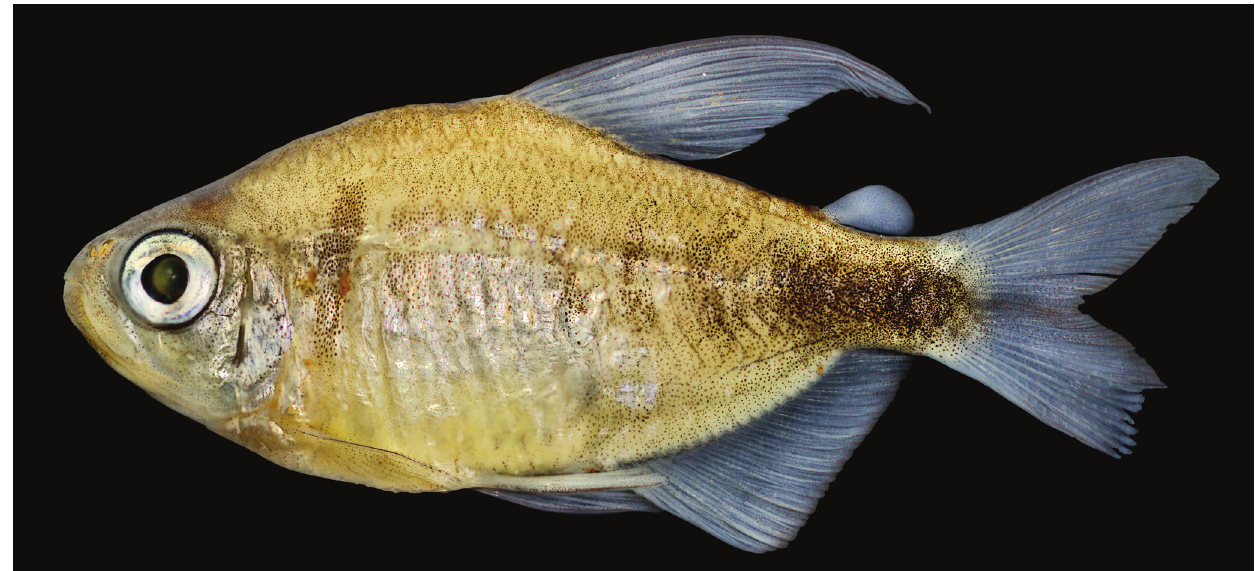
Fig. 7. Hyphessobrycon loweae , MZUSP 101404, 29.0 mm SL, male, Brazil, Mato Grosso State, rio das Mortes (rio Araguaia/ Tocantins basin).